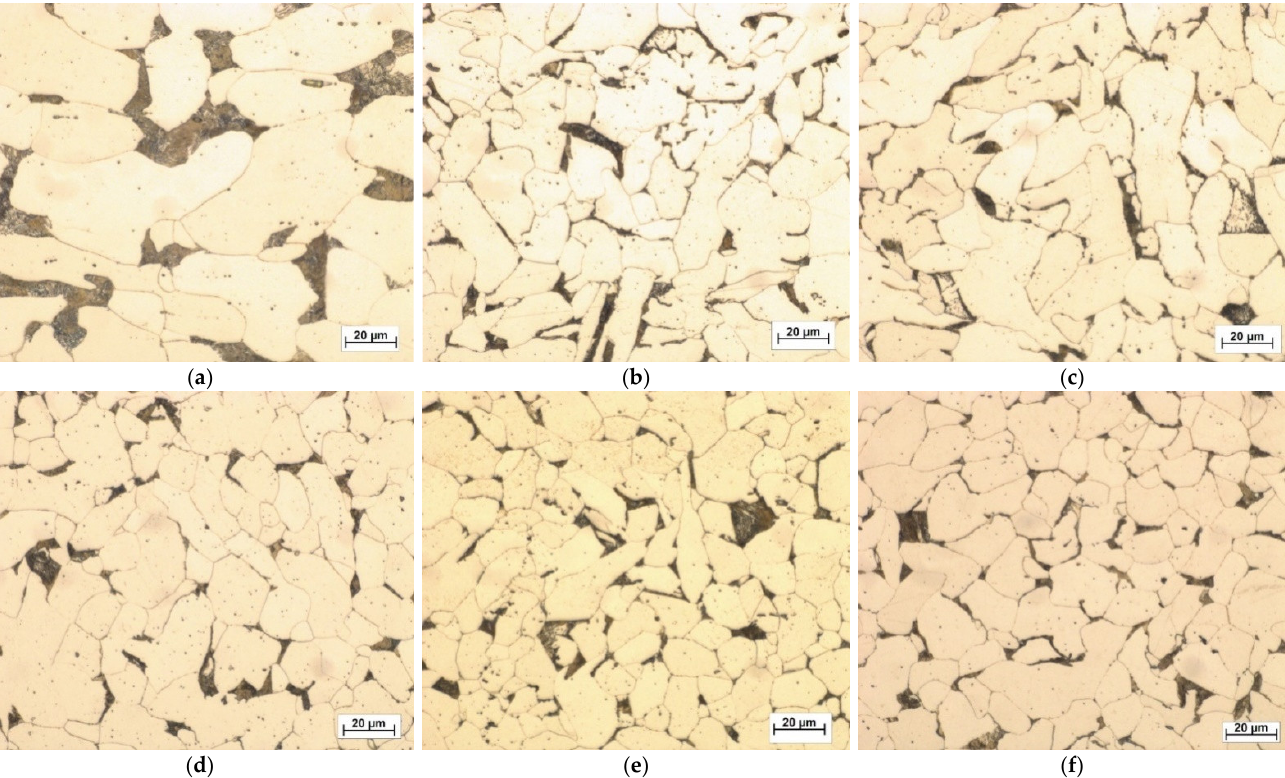
Figure 11. Microstructure of non-forging sample ( a ) and forging samples with relative reduction 10% ( b ), 20% ( c ), 30% ( d ), 40% ( e ) and 50% ( f ).